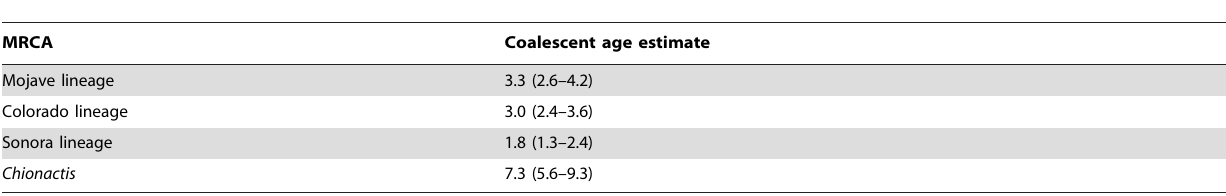
Table 1. Divergence time estimates from BEAST analyses.